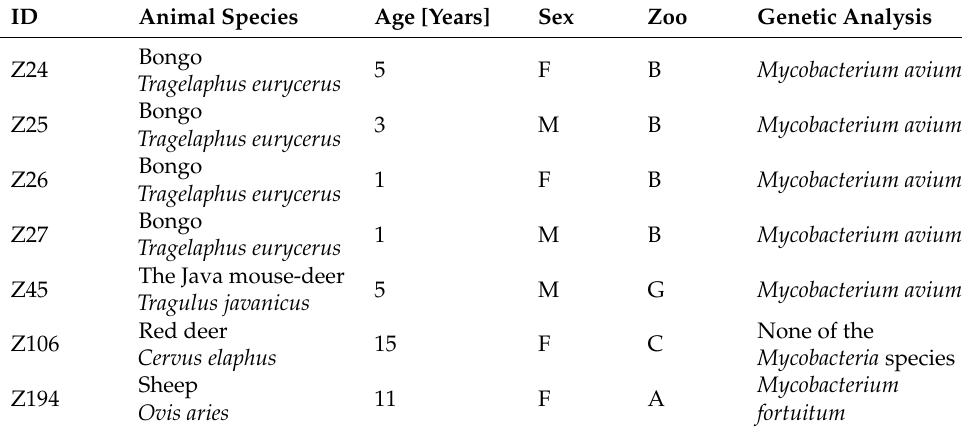
Table 2. Animals with positive mycobacteria culture results.